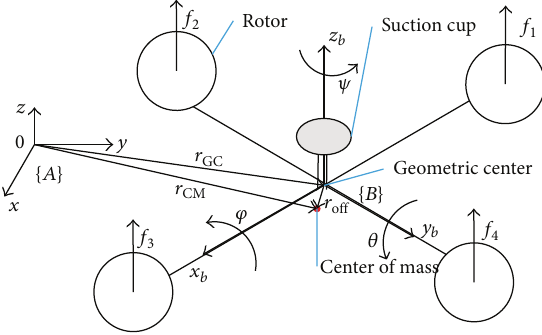
Figure 3: Free body diagram and coordinate